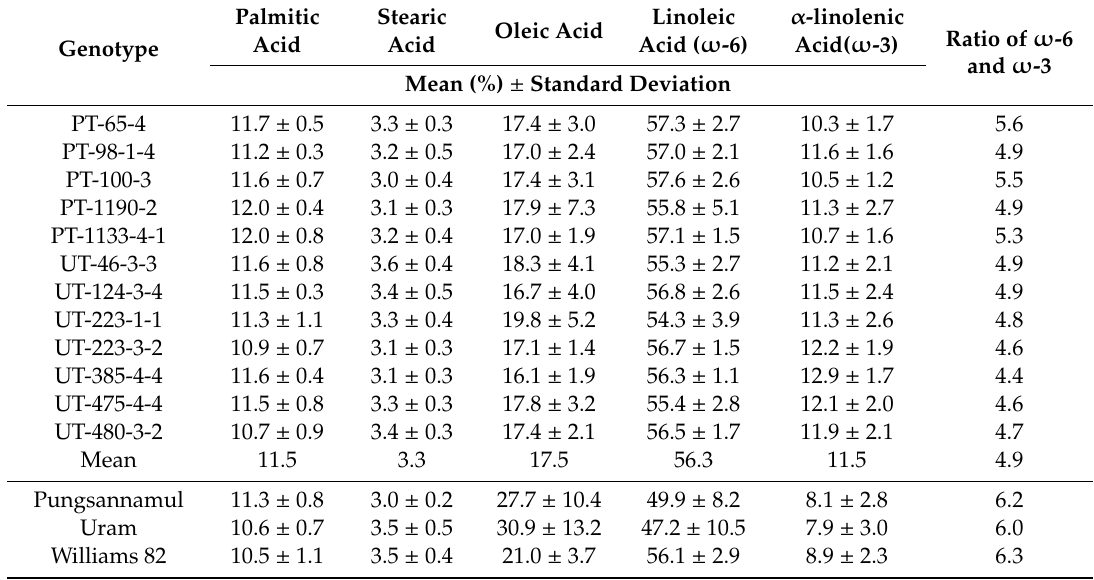
Table 4. Concentration of fatty acids of soybean genotypes averaged in eight di ff erent environments. Palmitic Stearic Acid Genotype